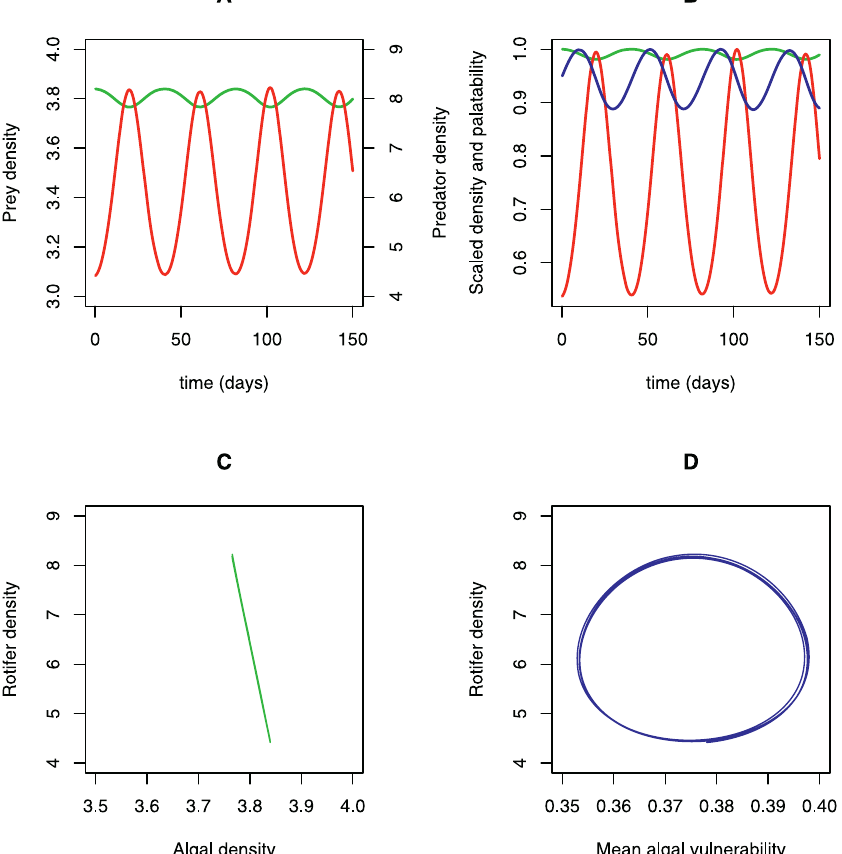
Figure 4. Numerical Solutions of the Chemostat Model Showing Cryptic Cycles Resulting from Rapid Prey Evolution (A) Total prey (green) and predator (red) densities. (B) Mean algal palatability to predators (blue), and total prey (green) and predator (red) densities expressed in dimensionless units by scaling relative to their maximum values over the time interval plotted, in order to show the relative scales of variability. As predicted by the asymptotic analysis, there are substantial (nearly 2-fold) proportional oscillations in predator density, moderate oscillations in prey palatability reflecting prey evolution, and very small oscillations in total prey density. (C) Phase-plane plot of predator and total prey densities. Because of the predator-prey phase relationship during evolution-driven cycles, the phase plot lies on a very narrow and nearly vertical band (Figure 2B). (D) Phase-plane plot of predator density and mean prey palatability, showing the ‘‘ predator-trait ’’ limit cycle. Predator and vulnerable prey parameters for this plot are the values estimated for our rotifer-algal chemostat system [42]; we set the dilution rate to d ¼ 1, and gave the defended prey type p 1 ¼ 0.1 (relative to p 2 ¼ 1 for the vulnerable prey) and a half-saturation constant for nutrient uptake 5% higher than that of vulnerable prey. The full rotifer– alga model includes predator age-structure and predator mortality within the chemostat, which are not in model (1); to eliminate these we set m ¼ k ¼ 0 in the full model. However, the behavior of the model is very similar if the estimated values ( m ¼ 0.055, k ¼ 0.4) are used, except that cycles then occur for a wider range of p 1 values.